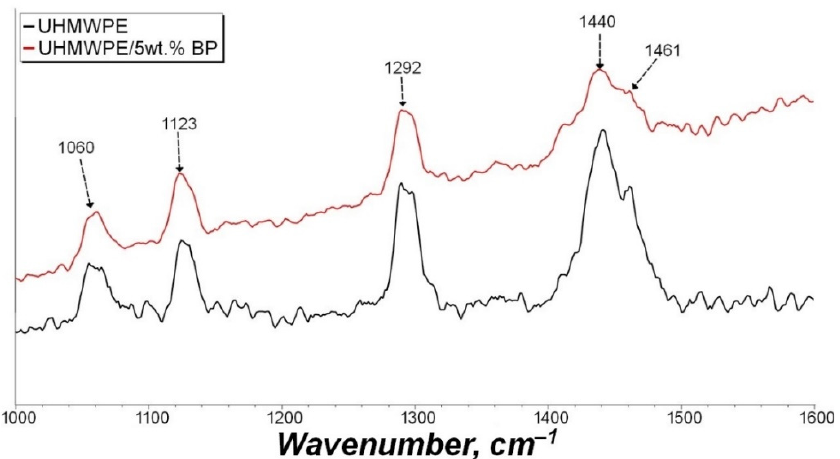
Figure 8. Raman spectra of the initial UHMWPE and composite UHMWPE/5 wt. % BP. As can be seen from Figure 8, in the Raman spectrum of UHMWPE and PCM, charac- teristic peaks in the region of 1060 and 1123 cm − 1 are visible, referring to symmetric